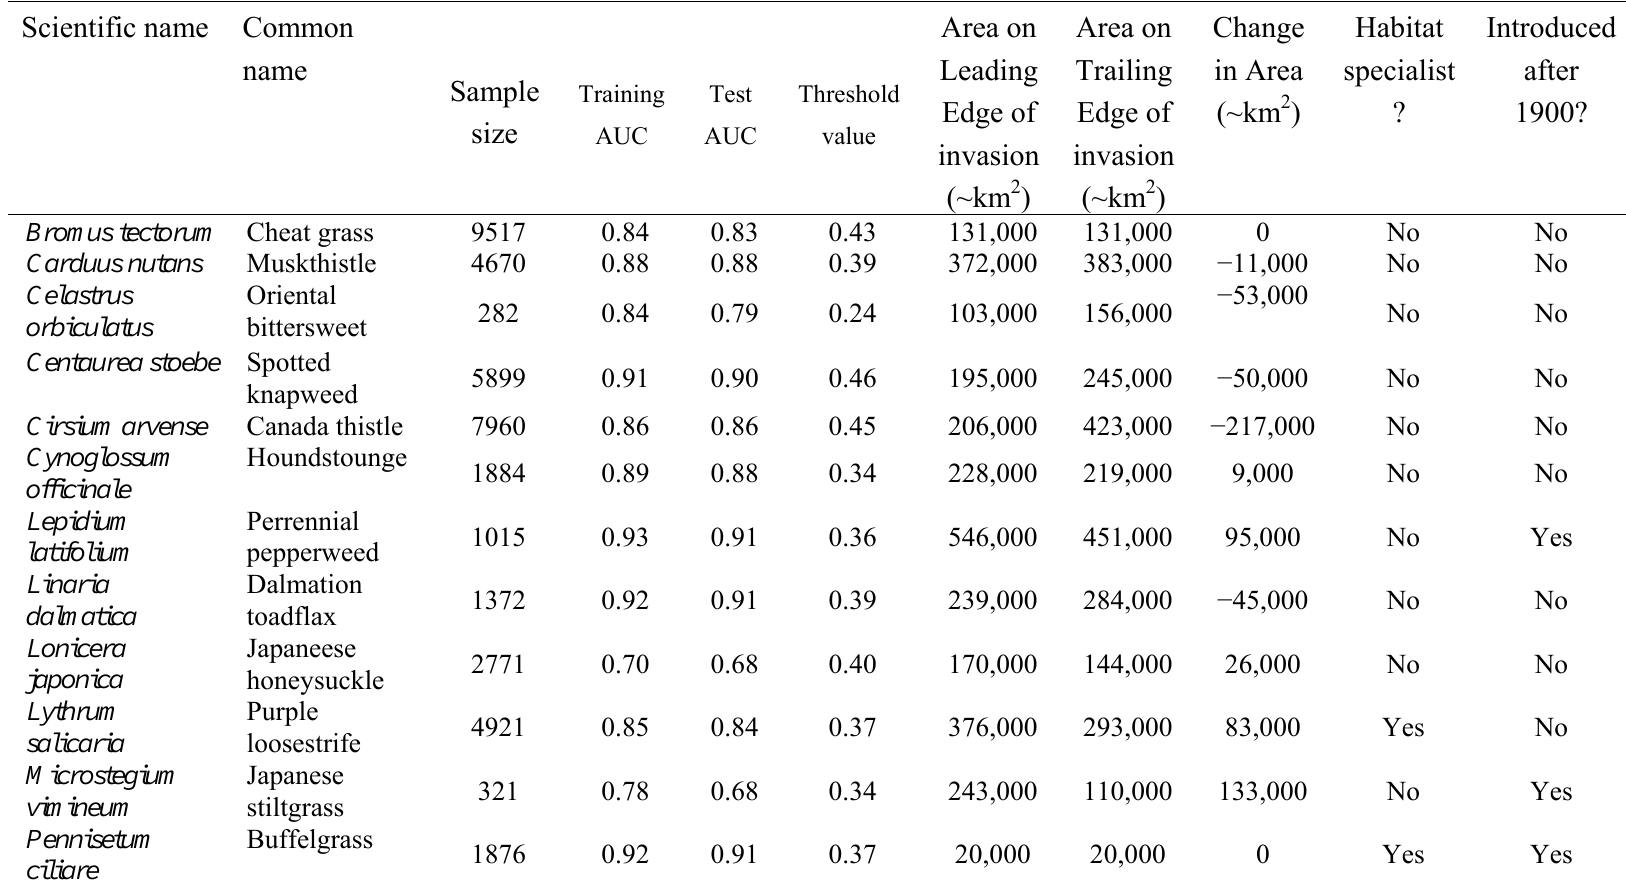
Table 1. Species modeled. The sample size is the number of points used, after duplicates were removed. The training Area Under the Curve (AUC) measures model performance of 70% of the data. The Test AUC measures model performance on the remaining 30% of the data. The Threshold value uses the 10 percentile logistic threshold to distinguish between potentially suitable or unsuitable habitat. The area on the leading edge of the invasion is the area of potential habitat that has shifted from potentially unsuitable to potentially suitable between the current model and the 2035 model. The area on the trailing edge of the invasion is the area of habitat that has shifted from potentially suitable habitat to potentially unsuitable habitat between the current model and the 2035